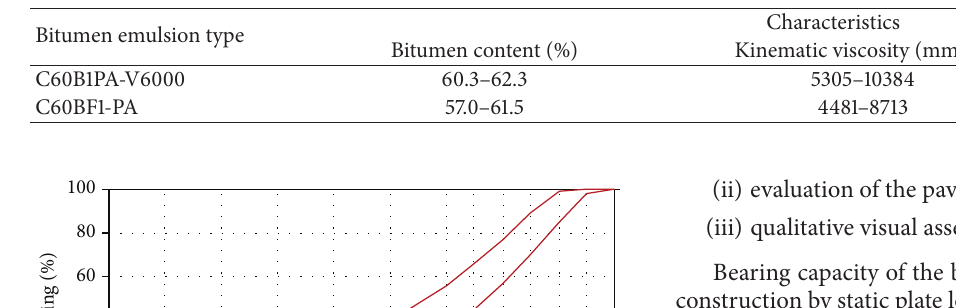
Table 3: Characteristics of bitumen emulsions.